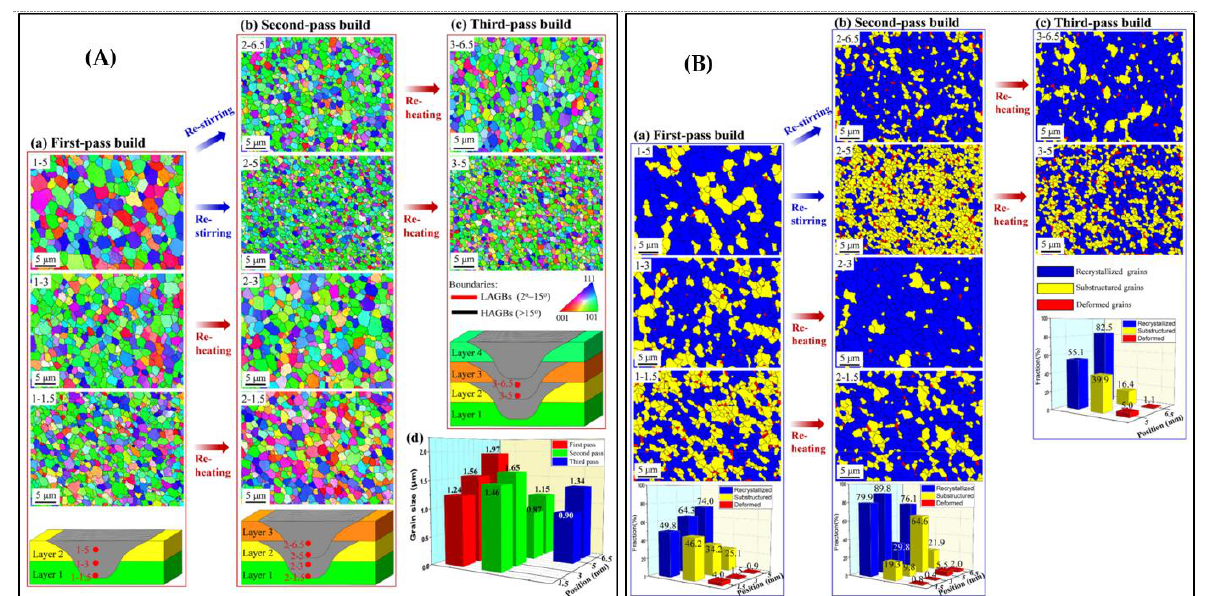
Figure 15. Effect of re-stirring and re-heating on grain characteristics of Al-7A04-T6 build: ( A ) Stir zone and distributions of grain sizes; ( B ) Fraction of grain type (re-crystalized, sub-structured, and deformed). (reprinted from [84] permission not required).